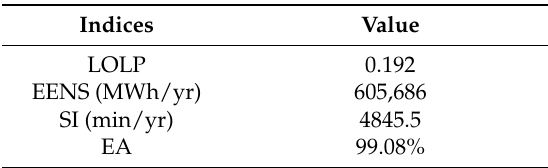
Table 3. Reliability indices of CIGRE B4 DC grid test